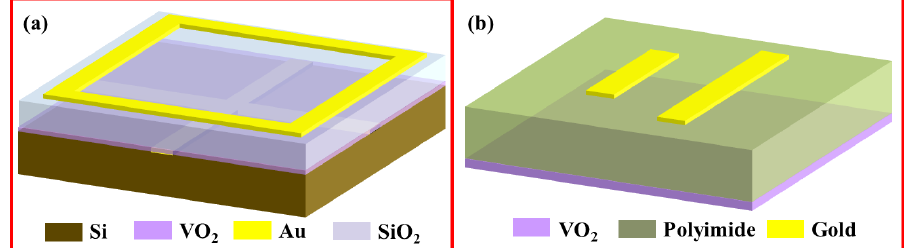
Figure 15. VO 2 -based transmissive metamaterial structures. ( a ) Structure designed by L. L. Chen et al. [157]; ( b ) structure designed by C. X. Liu et al. [159].